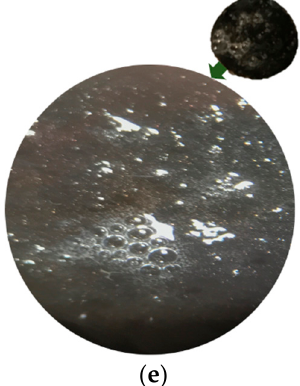
Figure 9. Nyquist plot of the half-cell during heating in the chamber of pure electrolyte graphite half-cell ( a ); ( b ) 1M LiPF 6 in EC/DMC + 5% wt. starch; ( c ) Nyquist plot of the half-cell during heating in the chamber for 10% wt. starch; ( d ) 20% wt. starch ( e ) electrode image after heating (5% wt. starch).